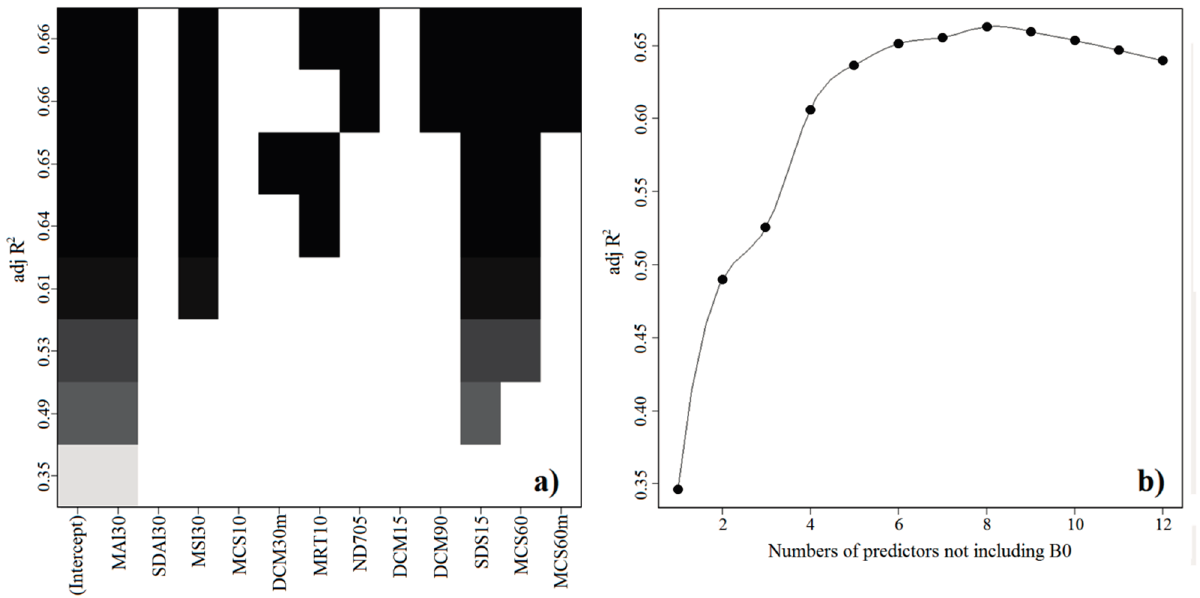
Figure 2. ( a ) Table of models showing which variables are in each model. The models are ordered by the adjusted R 2 . MAl30: mean altitude (30 m); SDAl30: standard deviation of altitude (30 m); MSl30: mean slope (30 m); MCS10: mean catchment slope (10 m); MRT10: MrRTF (10 m); ND705: NDVI (30 m); DCM15 digital crown model (15 m); DCM90: median digital crown model (90 m); SDS15: standard deviation of the slope (15 m); MCS60: mean catchment slope (60 m); MMCS60: median catchment slope (60 m). Note that the axis is not quantitative but ordered. The darkness of the shading simply represents the ordering of the adjusted R 2 values ( b ) Plot of the number of predictors that maximize the adjusted R 2